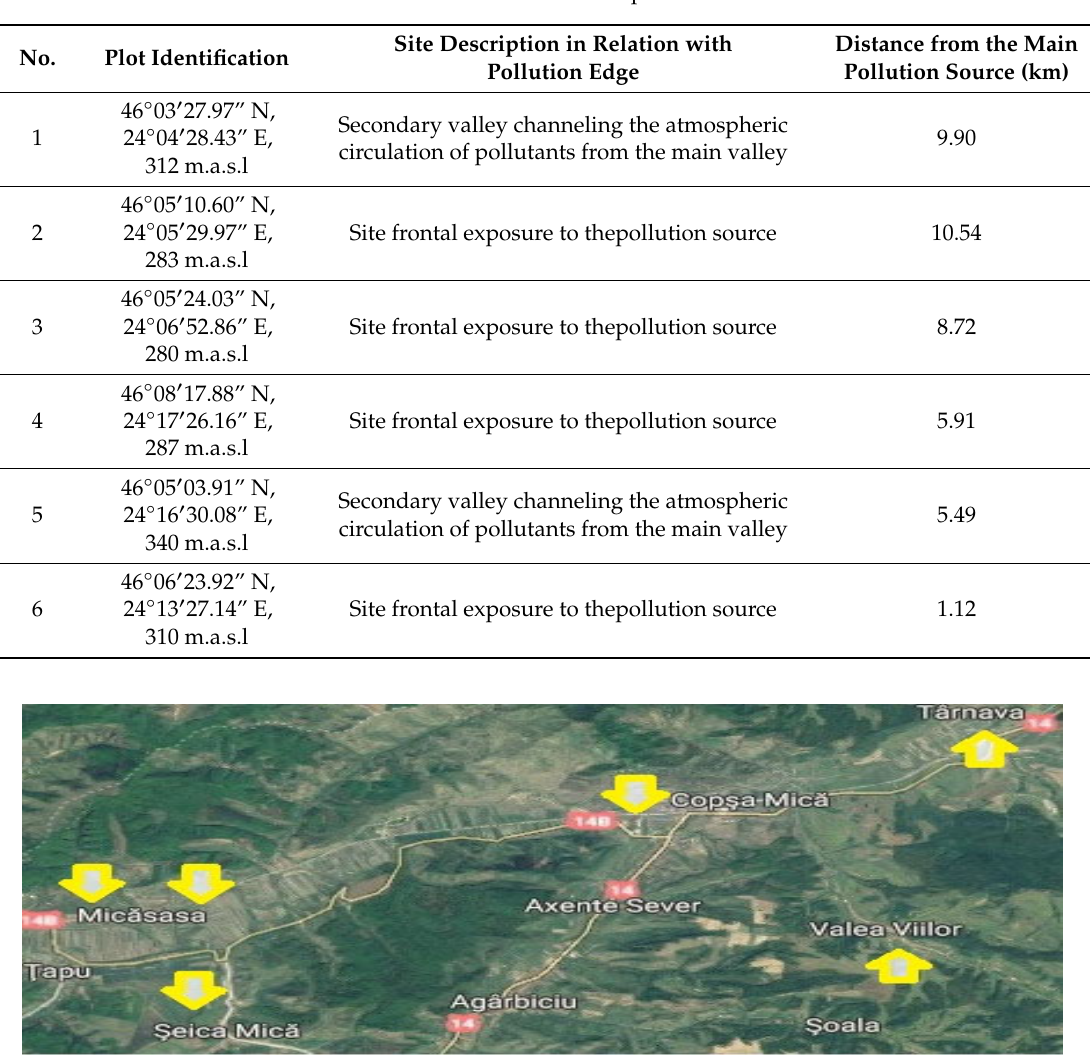
Figure 1. Map of the honey sampling localities.